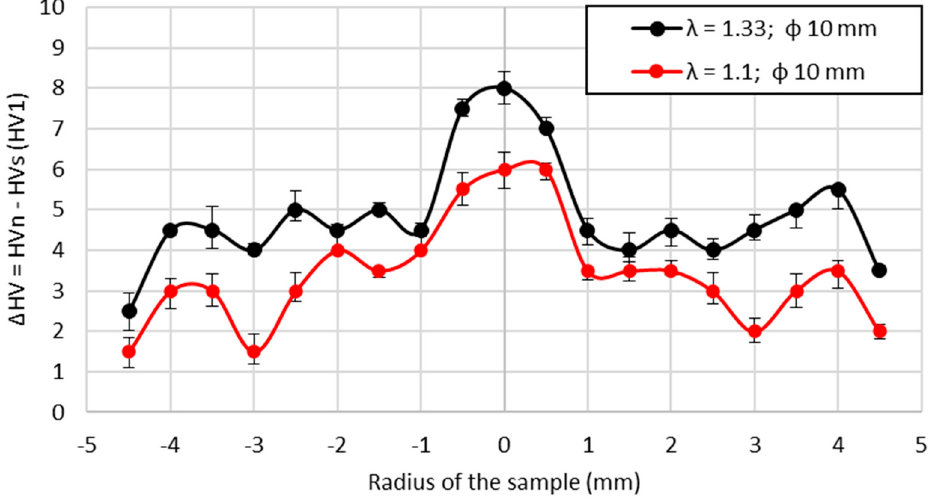
Figure 13. The difference in hardness measurements of the cross-section in non-stationary conditions (HVn) and stationary conditions (HVs) .